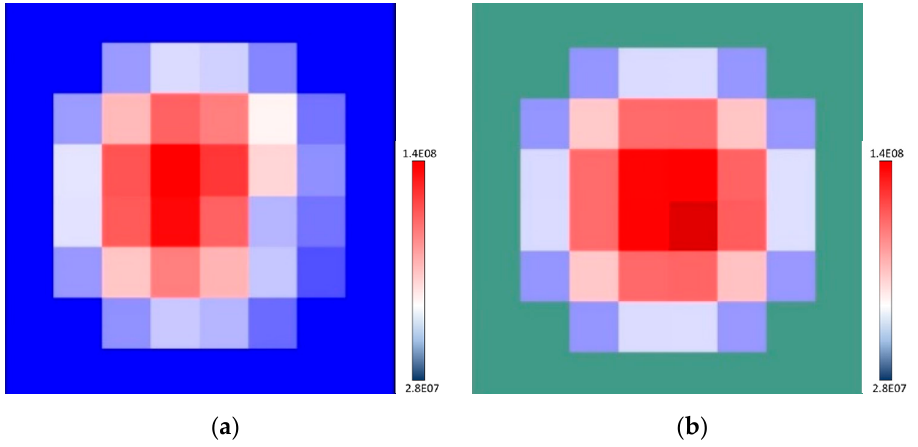
Figure 23. Impact of fuel properties: ( a ) power; ( b ) reactivity.